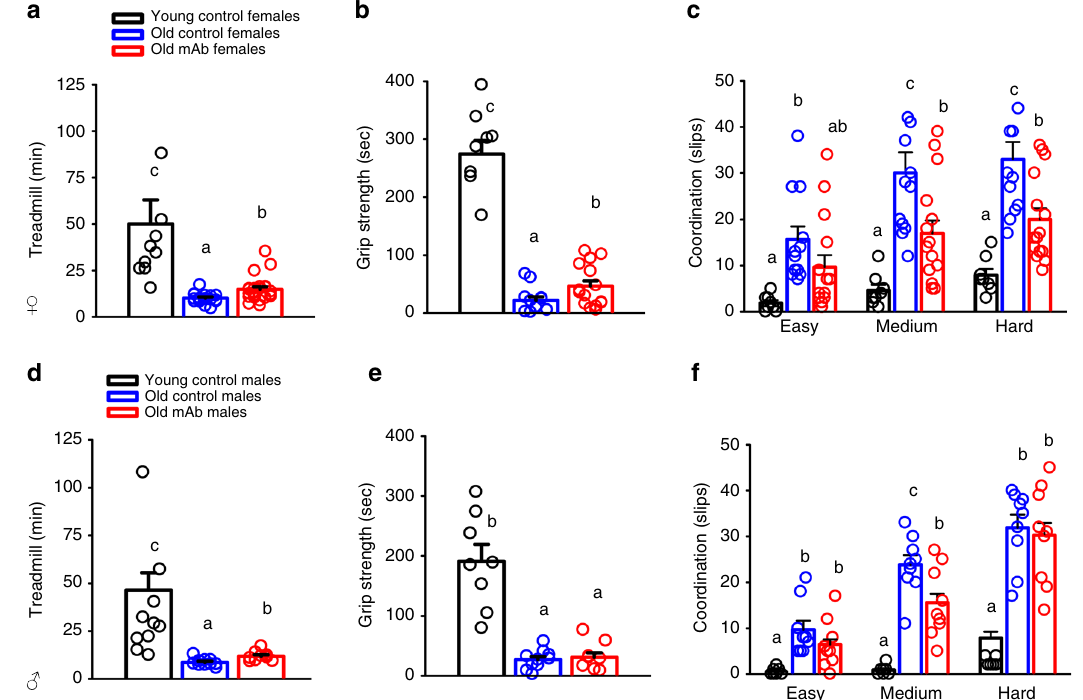
Fig. 3 L2-Cmu preferentially improves female healthspan. Following 6 mo of mAb treatment, several functional measures of healthspan were assessed, including exercise tolerance in female [Young ( n = 8), Old Con ( n = 16), and Old mAb ( n = 15)] and male mice [Young ( n = 10), Old Con ( n = 9), and Old mAb ( n = 9)], grip strength in female [Young ( n = 8), Old Con ( n = 12), and Old mAb ( n = 9)] and male mice [Young ( n = 10), Old Con ( n = 10), and Old mAb ( n = 9)], and balance beam in female [Young ( n = 8), Old Con ( n = 12), and Old mAb ( n = 15)] and male mice [Young ( n = 8), Old Con ( n = 9), and Old mAb ( n = 9)]. a – c In females, mAb led to signi fi cant improvements in exercise tolerance (~50% over Old Con), grip strength (two-fold over Old Con), and motor coordination. d – f In males, L2-Cmu improved exercise tolerance by ~28%, but did not lead to improvements in grip strength, while motor coordination was only modestly improved on a medium dif fi culty beam. Bars represent mean ± s.e.m. Dot plots overlaid on bar graphs represent individual data points. Different letters denote a signi fi cant difference between groups by Tukey HSD, P ≤